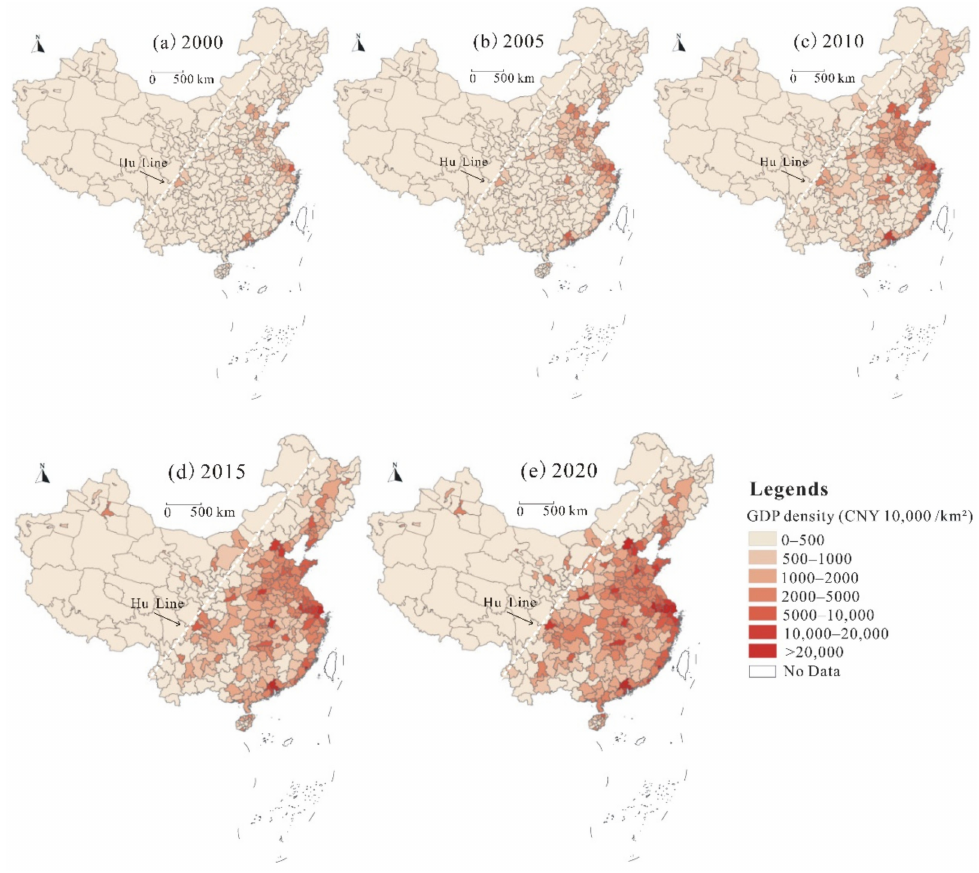
Figure 4. Spatial distribution characteristics of gross domestic production density (GD) in Chinese Mainland during the investigation